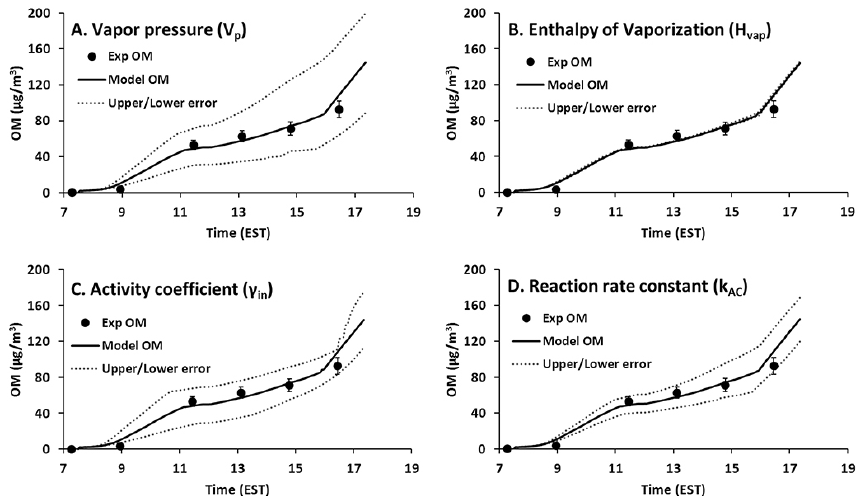
Fig. 6. Uncertainty of model prediction due to variation of major model parameters. Solid lines are for model prediction, symbols are for experimentally measured OM, and dashed lines are sensitivity test results (upper and lower cases within given variations of model parameters). The simulations employ the environmental condition of the experiment performed on 6 January 2012 with 190ppb of the initial toluene concentration (see Fig. 3a). (A) The estimated errors associated with vapor pressure ( V P ) of lumping species were predicted with increasing/decreasing V P by 100%/50%. (B) The estimated errors associated with enthalpy of vaporization ( H vap ) of lumping species were predicted with increasing/decreasing H vap by 10%. (C) The estimated errors associated with activity coefficients ( γ in ) of lumping species in the inorganic phase were predicted with the γ in increased by 3 times (200% increase) and decreased by one-third. (D) The estimated errors associated with reaction rate constants ( k AC ) of lumping species in both the inorganic phase and organic phase were predicted with increasing/decreasing rate constants by